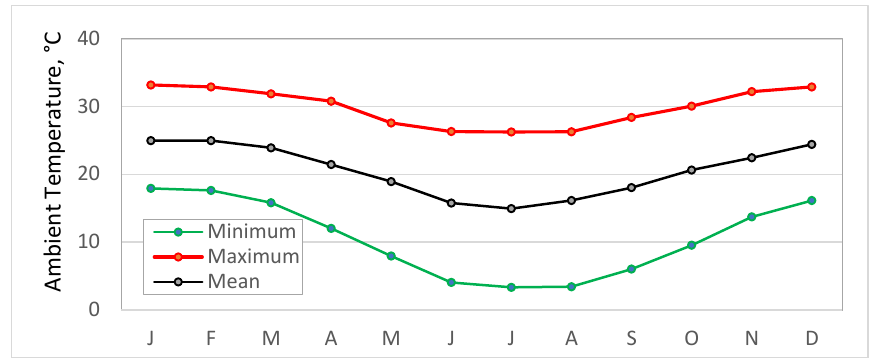
Figure 3. Monthly ambient temperature profiles.